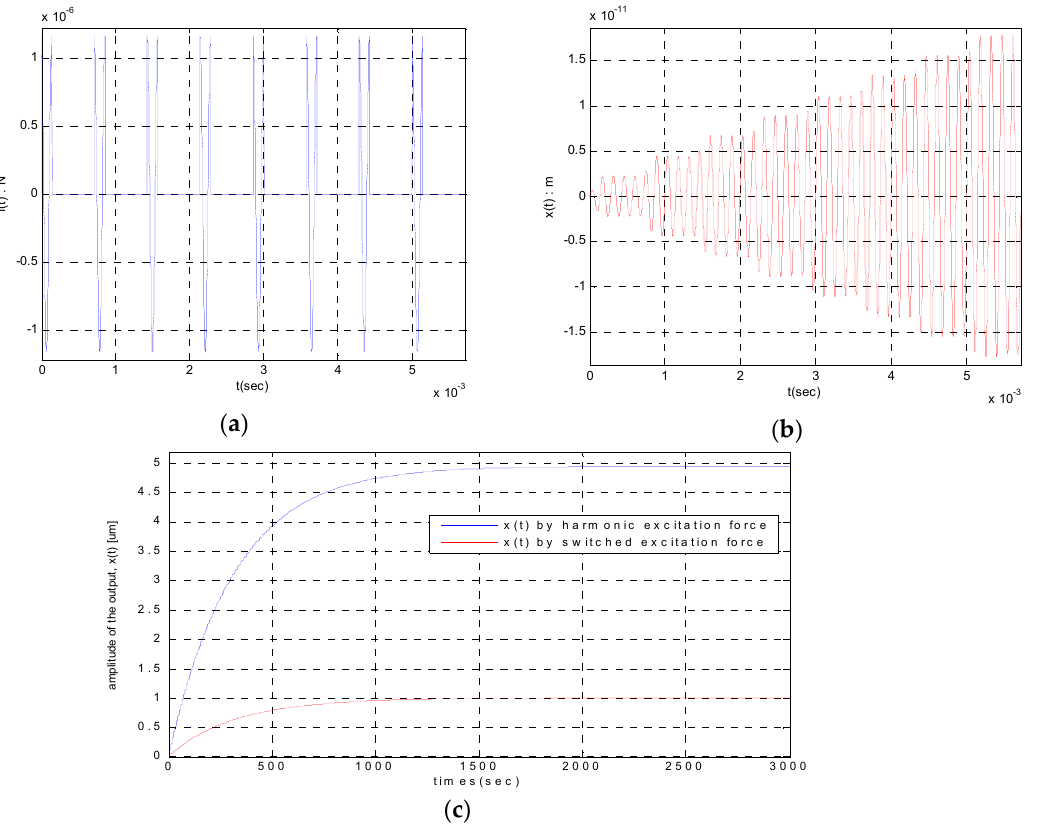
Figure 3. The displacement output by switched harmonic excitation: ( a ) The control force input (N); ( b ) The displacement output ( t ď 40 ¨ 2 π ω s); ( c ) The displacement output ( t ď 3000 s).